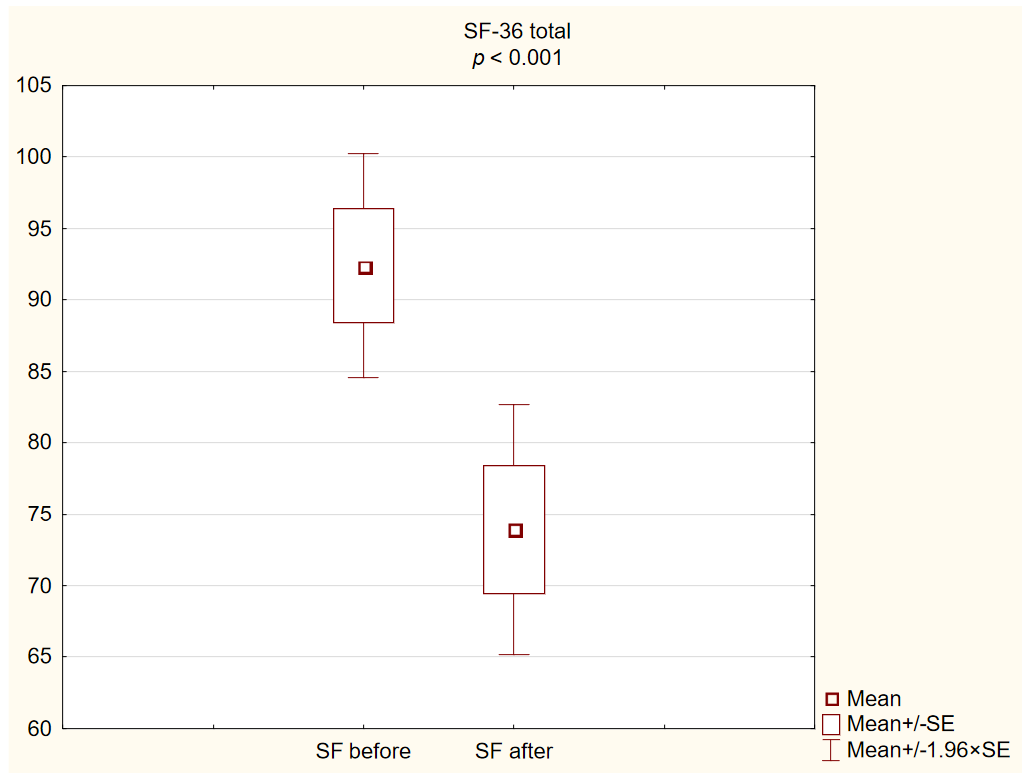
Figure 1. Quality of life among patients before and after the rehabilitation program, Student ’ s t-test.